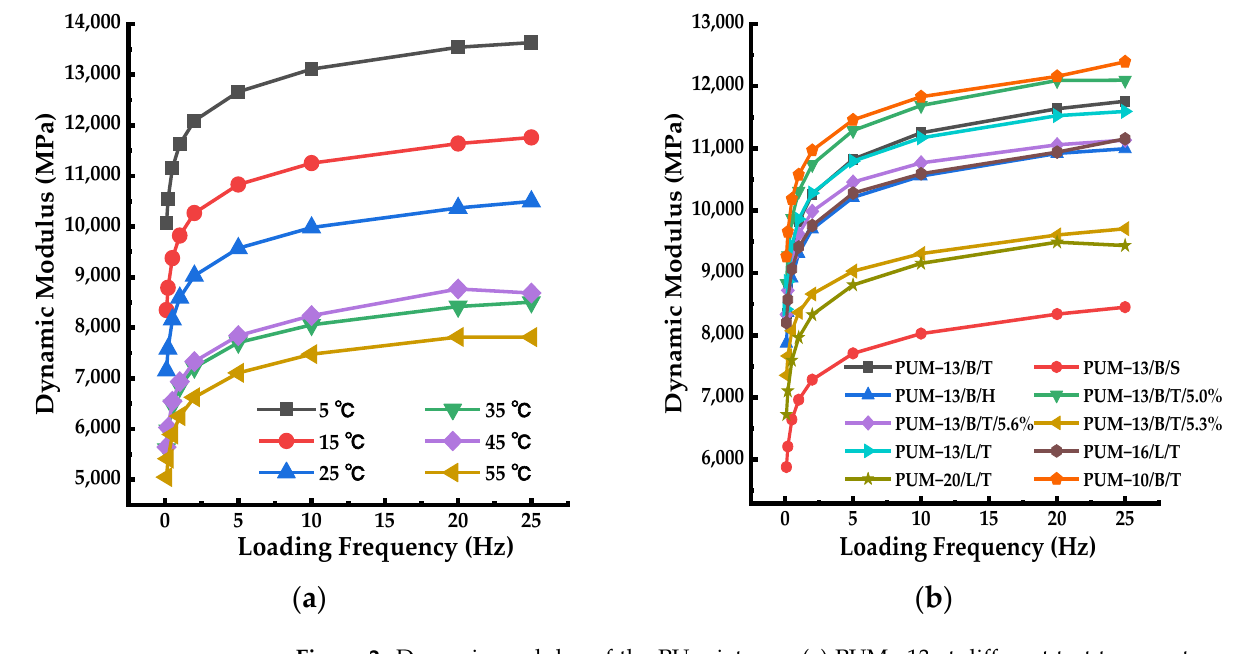
Figure 2. Dynamic modulus of the PU mixtures. ( a ) PUM − 13 at different test temperatures and loading frequencies. ( b ) Different PU mixtures at 15 ◦ C.